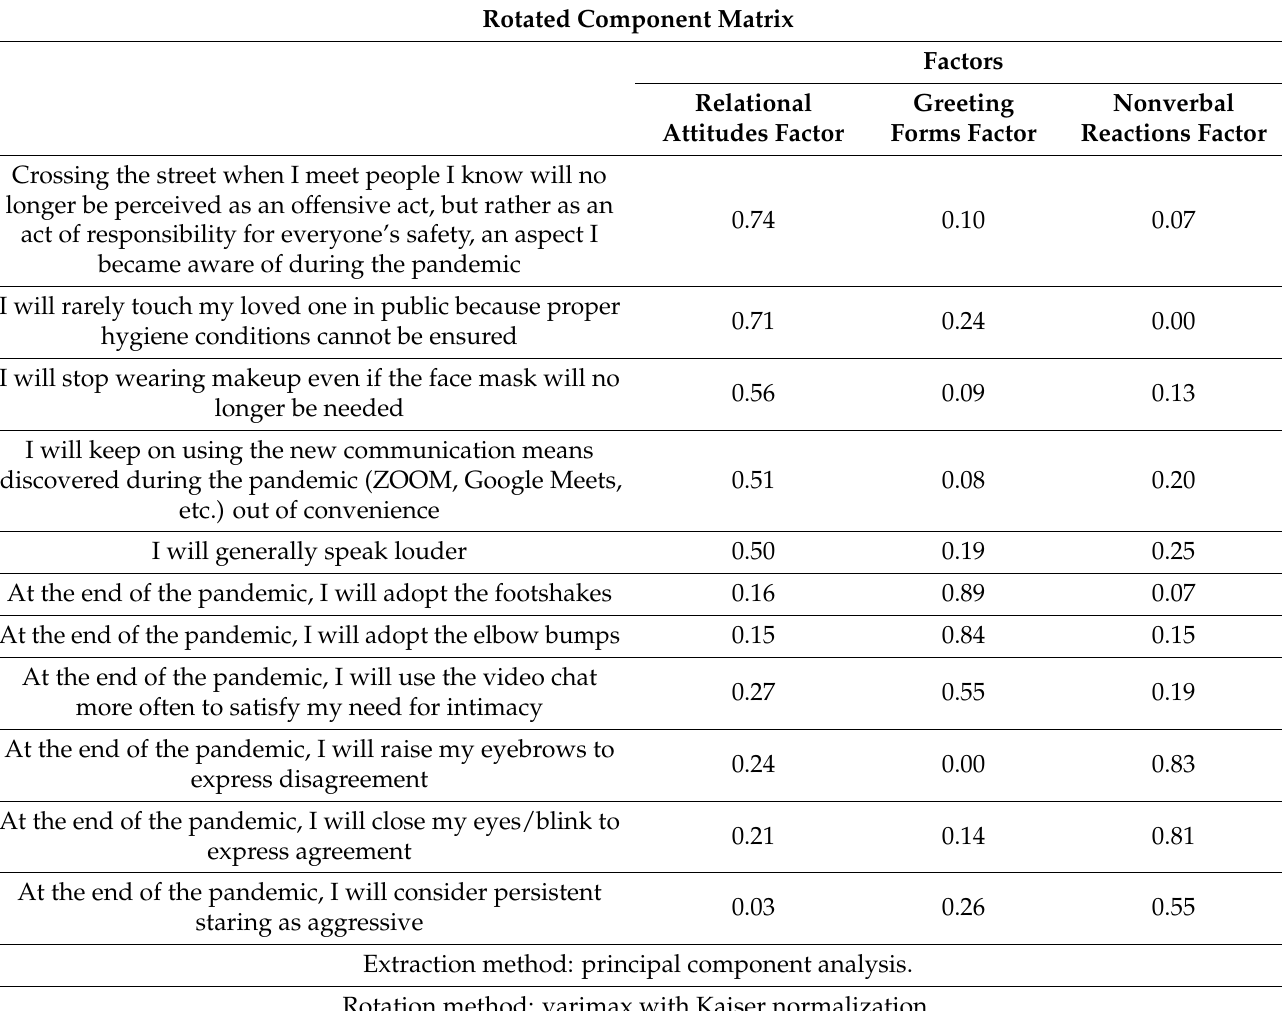
Table 10. Table of variable–value loadings in each extracted factor, obtained after factor rotation. Rotated Component